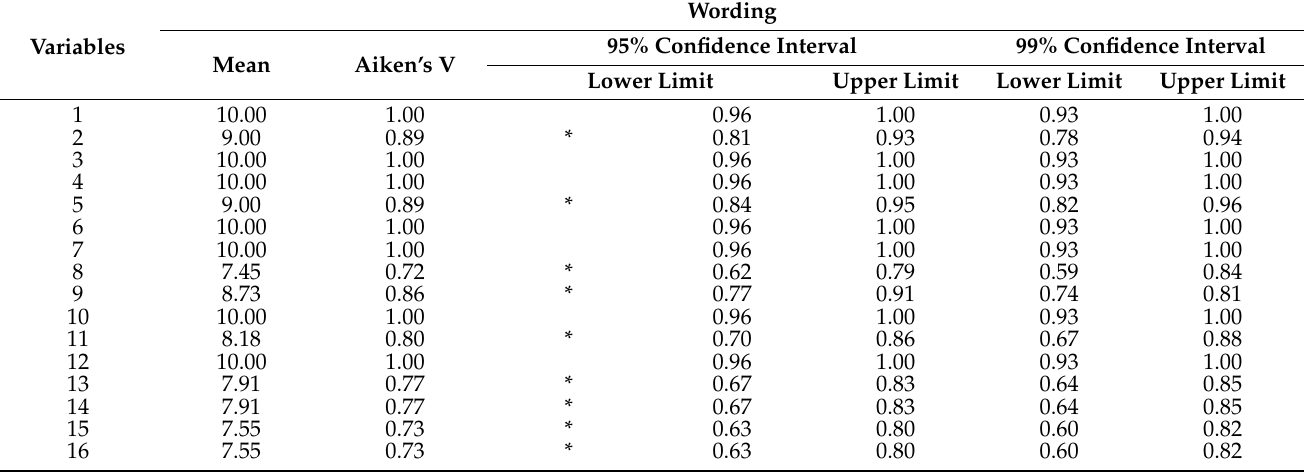
Table 5. Results of Aiken’s V coefficient and confidence intervals